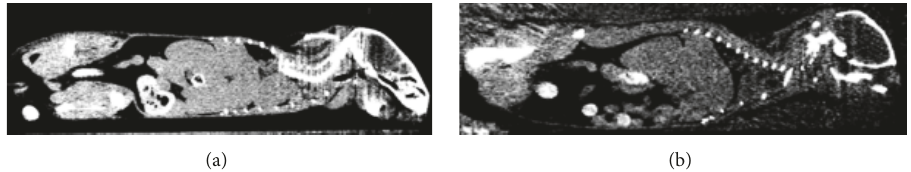
Figure 2: CT assessment of volume change due to freezing. Images are from a postmortem mouse before (a) and after (b) freezing. Images are from similar locations, but one should not compare details in the images. Images are rendered with the same level and window settings, 0 and 400, respectively. Clearly, after freezing, images are darker with reduced CT number in HU indicating volume expansion with